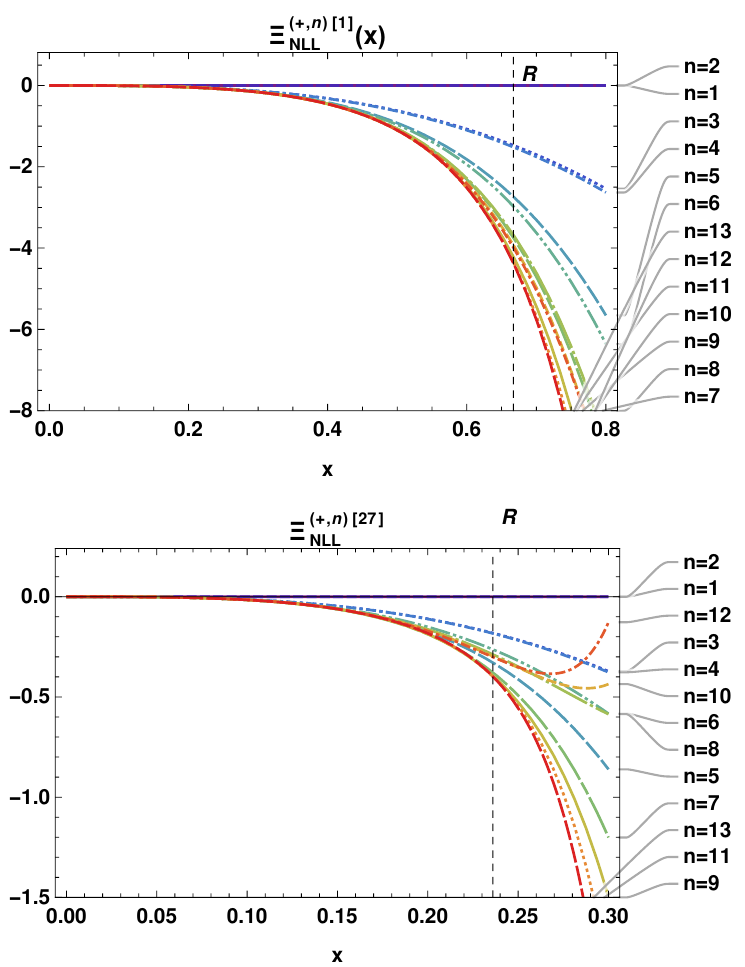
Figure 12 . Partial sums of the infrared-renormalized amplitude coe(cid:14)cients (cid:4) (+ ;‘ ) for the singlet (upper plot) and the 27 colour representation (lower plot). The dashed vertical line represents the radius of convergence, R , determined by the pole closest to x = 0, using the method of Pad(cid:19)e